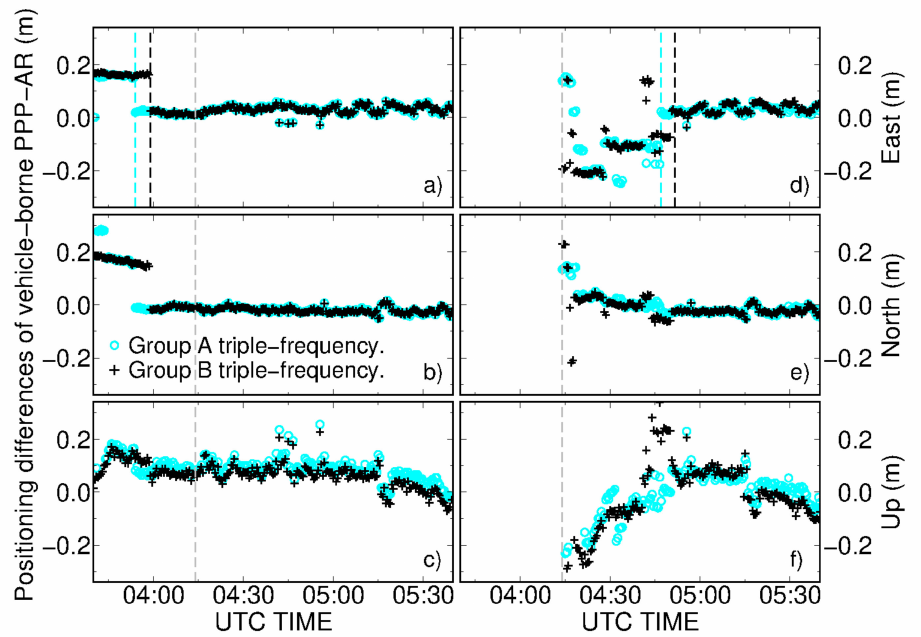
Figure 6. Positioning differences of east, north, and up components between vehicle-borne PPP-AR and short-baseline solutions. Panels ( a – c ) are solutions which were processed from the beginning of the static period while in panels ( d – f ) we only processed the epochs when the vehicle was moving. Dashed cyan and black lines represent the epochs when Group A and Group B triple-frequency PPP-AR converged successfully. Finally, dashed gray lines mark the epoch from which the vehicle began to